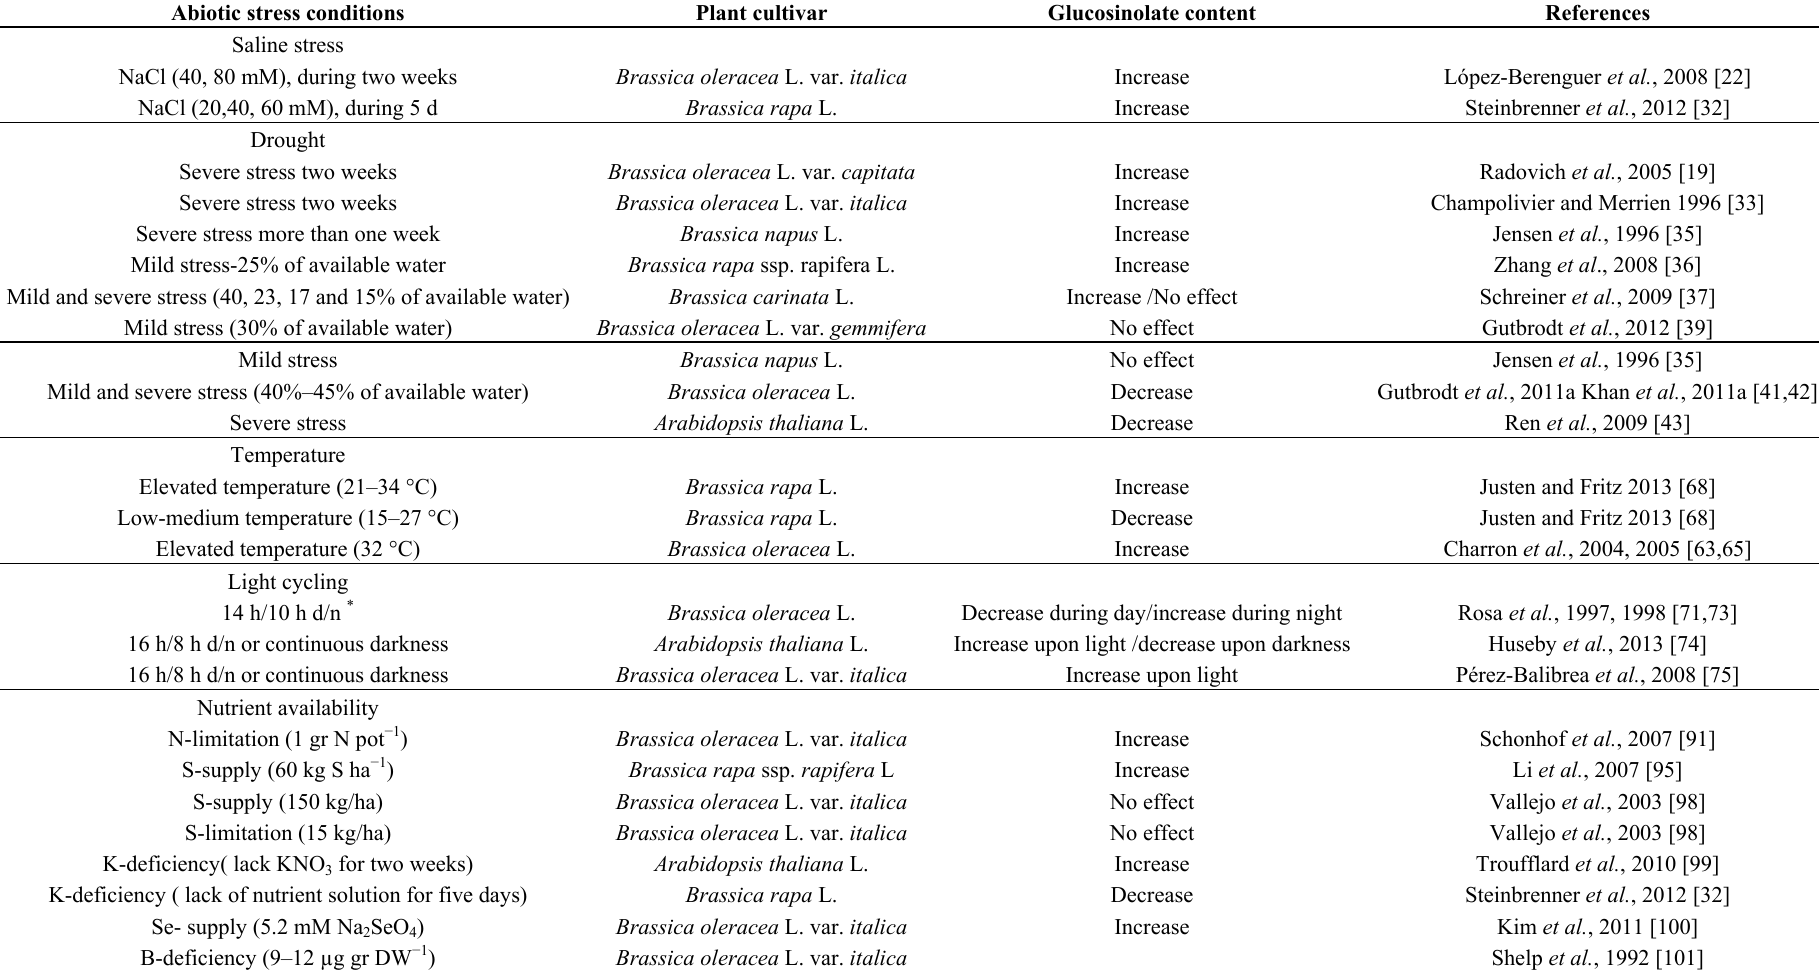
Table 1. Effect of different abiotic stress conditions on glucosinolate production of different